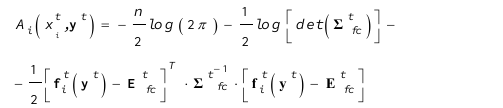
In Equation 3, E t fc and  t fc is the mean and co-variance matrix of the features of class c , respectively. For CRF multi they are determined from the features f it ( y t ) in training sites individually for each epoch t and each class c . With t =1 Equation 3 is also applied for CRF all but using the concatenated feature vector f iall . The spatial interaction potential IS ijt is a measure for the influence of the data y t and the neighboring labels x jt on the class x it of site i at epoch t . For both approaches CRF all (with t =1) and CRF multi we applied the identical implementation and parameters to ensure comparability of the results. The data are represented by site-wise vectors of interaction features  ijt ( y t ) (Kumar and Hebert, 2006). We use the component-wise differences of the feature vectors f it respectively f iall ,